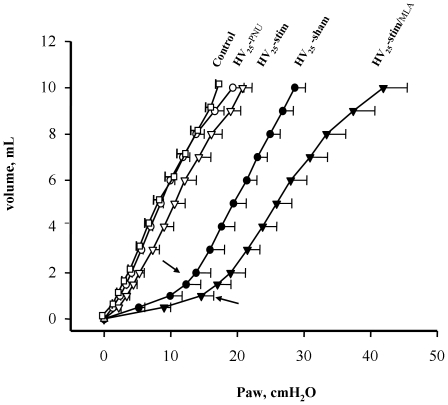
Respiratory system compliance.The pressure-volume curves during inflation in rats exposed to high stretch ventilation show the rightward shift and a lower inflection point (arrows) in unprotected groups. The reference curve from animals ventilated with non-injurious ventilation for two hours is also shown (Control). HV25-PNU: pre-treated with alpha7 nicotinic acetylcholine receptors agonist PNU (empty circles). HV25-stim: associated with vagal electrostimulation (empty reversed triangles). HV25-sham: pre-treated with saline (plain circles). HV25-stim/MLA: associated with vagal electrostimulation and pre-treatment with alpha7 nicotinic acetylcholine receptor blocking agent MLA (plain reversed triangles)